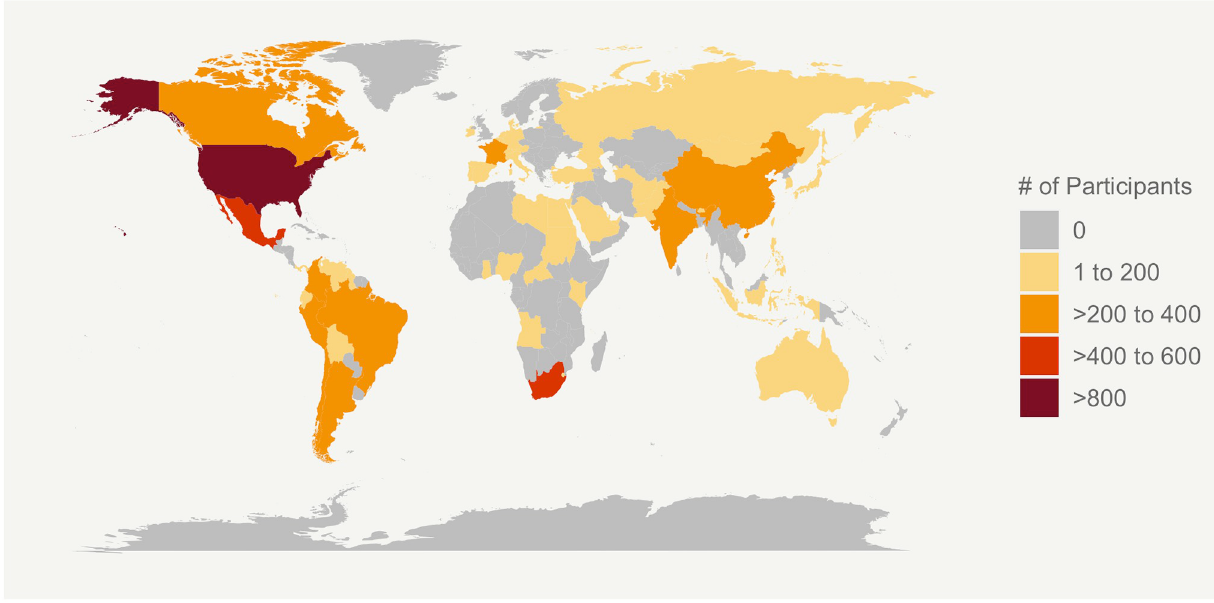
Fig 1. Geographic distribution of study participants by country a . a The world map was generated using open-source data in the R statistical package “rworldmap” (https://cran.r-project.org/package=rworldmap).